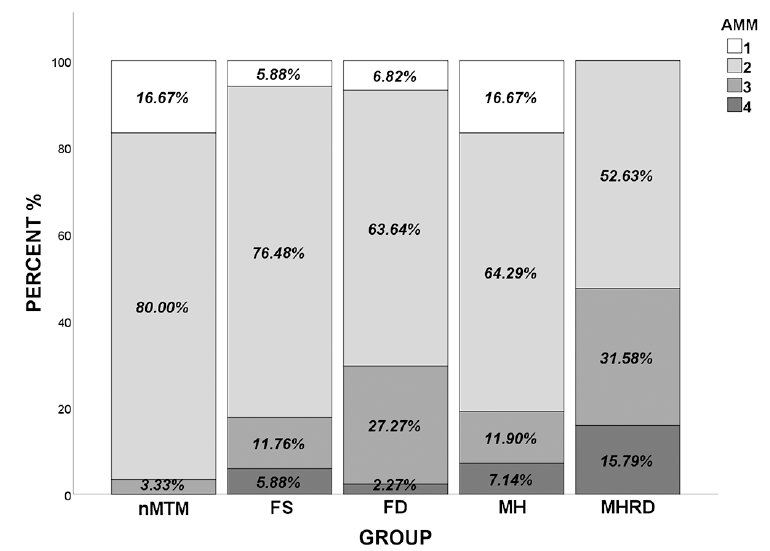
Figure 4. Distribution of the different categories of atrophic myopic maculopathy in four different types of MTM and in highly myopic eyes without MTM. AMM: atrophic myopic maculopathy, MTM: myopic tractional maculopathy, FS: foveoschisis, FD: foveal detachment, MH: macular hole, MHRD: macular hole with retinal detachment.